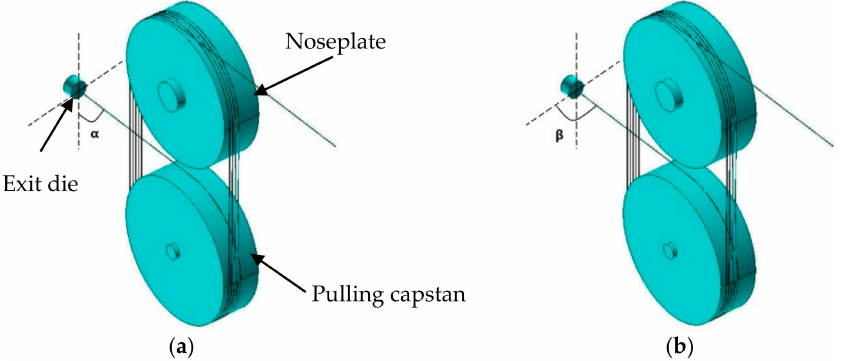
Figure 13. Schematic illustration of characteristic angles between an exit die and a pulling capstan: ( a ) angle α in the vertical plane; ( b ) angle β in the horizontal plane.